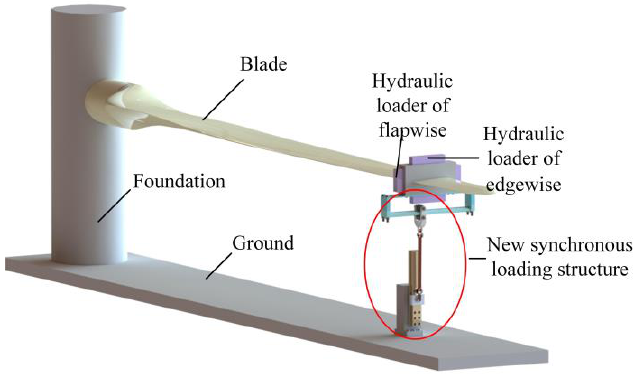
Figure 14 A newly designed biaxial force decoupling device.